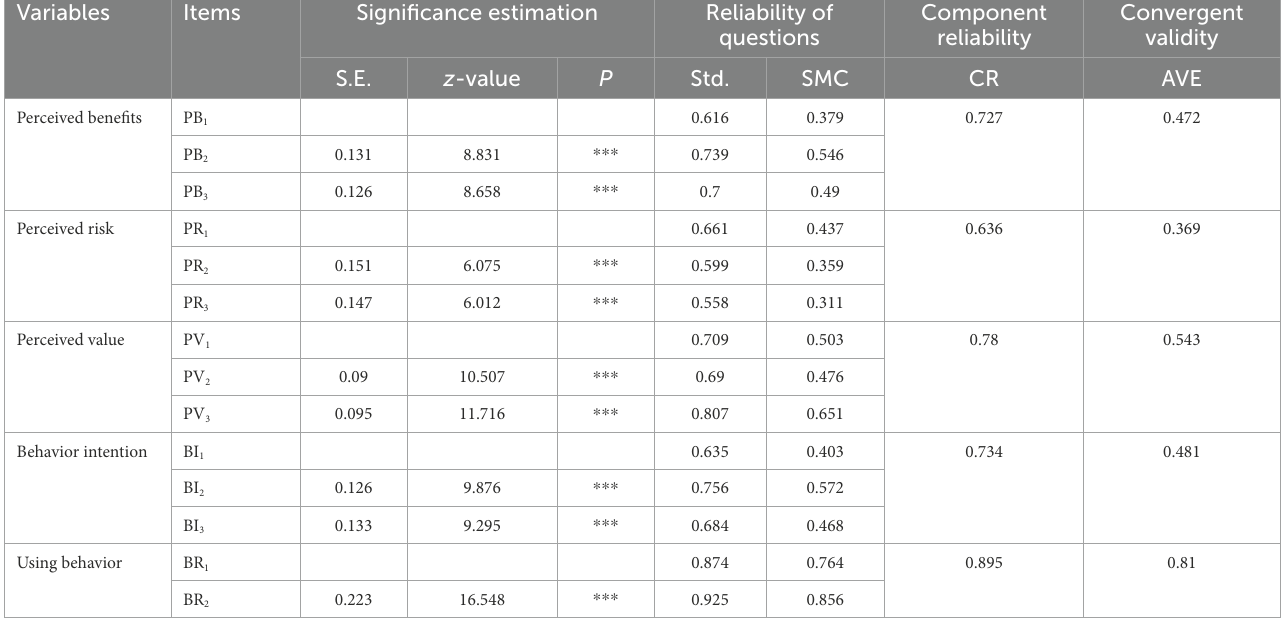
TABLE 3 Convergent validity table. Variables Items